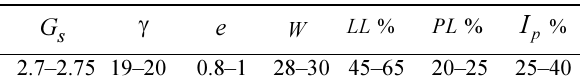
Table 3. Characteristic properties of Yoldia clay